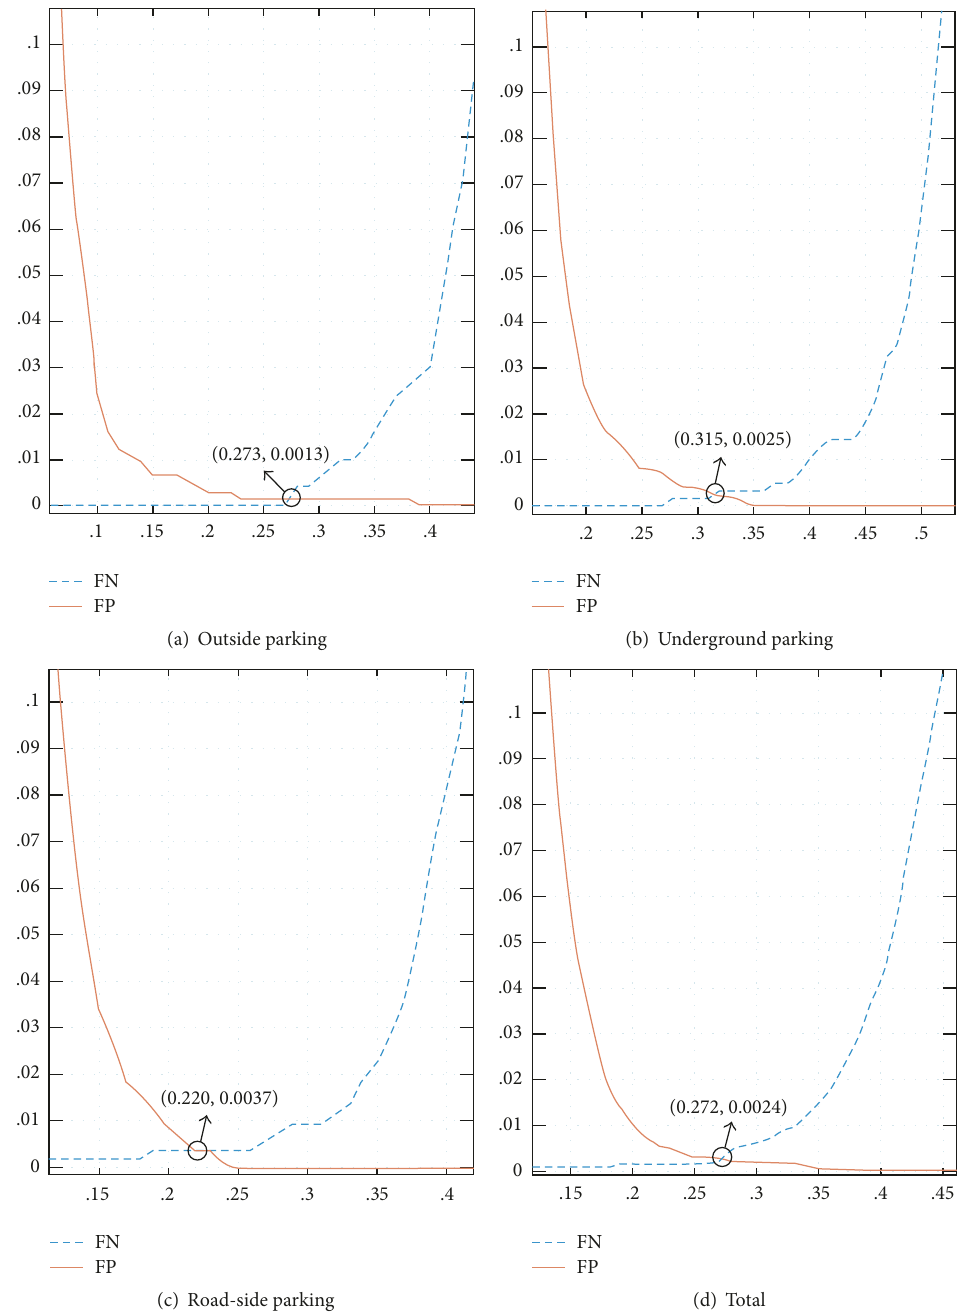
Figure 5: False Negative rate and False Positive rate as a function of the threshold. (a) is the result at an outdoor parking lot, where the equal error rate is 0.0013 at a threshold of 0.273. (b) is the result at an underground parking lot, where the equal error rate is 0.0025 at a threshold of 0.315. (c) is the result at a road-side parking lot, where the equal error rate is 0.0037 at a threshold of 0.220. (d) is the result regardless of the environmental condition, where the equal error rate is 0.0024 at a threshold of